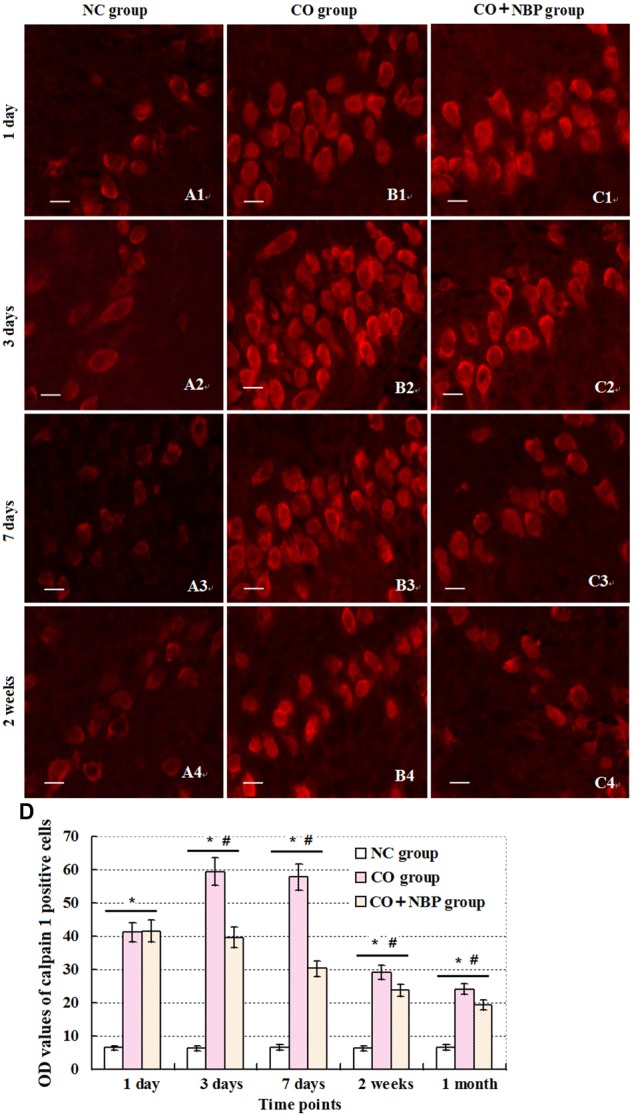
Changes of calpain 1 in hippocampus in each group. Calpain 1 positive cells were observed in hippocampal tissue in NC group, and mainly located in cytoplasm (A1–C4). After exposure to CO, the amount of calpain 1 positive cells was gradually increased, peaked between days 3 and 7, and maintained at relatively higher levels till 2 weeks in contrast to those in NC group (n = 4, P < 0.05). In contrast, administration of NBP could significantly decrease the expression levels of calpain 1 protein in comparison to that of CO poisoning group at the same time (n = 4, P < 0.05). (D) Histogram of the OD values of calpain 1 positive cells in each group at different time points.∗Compared with NC group (n = 4, P < 0.05); #compared with CO group (n = 4, P < 0.05). F = 11.525∼21.618. Scale bar is 30 μm.